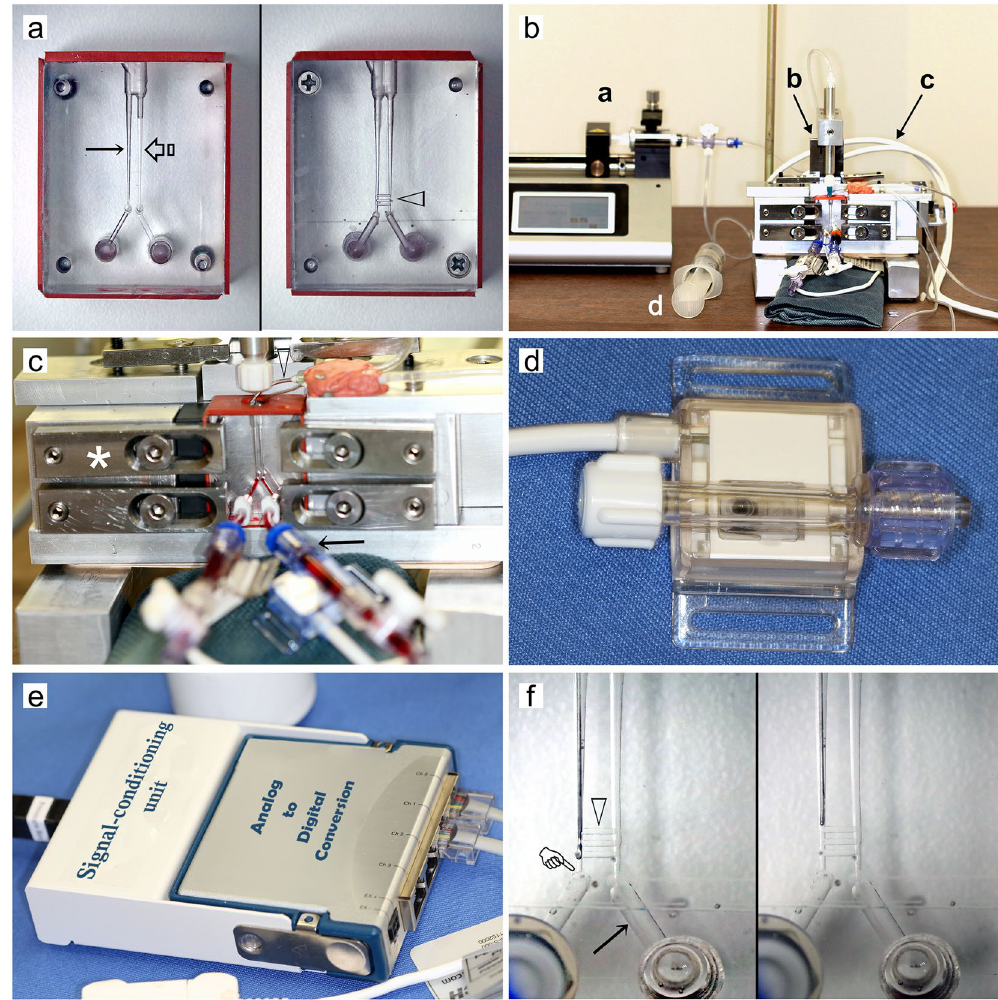
Figure 2. Experimental setup. ( a ) Two models simulating double canals in a single root. Left : The “separate canal model” with two unconnected parallel canals, one for pressure measurement with the irrigation needle inserted (arrow) and the other without needle insertion (open arrow). Right : The “canal anastomosis model” with a similar set of simulated parallel canals connected by anastomosing lateral channels (open arrowhead). The two holes at the bottom of each block are Luer ports for connecting the apical termination of each canal to a pressure sensor. ( b ) Overview of the experimental setup. b-a: precision syringe pump; b-b: Positioning device with inserted metal gauge blocks for precise control of the irrigation needle position within the canal space; b-c: Data acquisition cables linking the pressure sensors (Fig. 2d) to the signal-conditioning unit (Fig. 2e). b-d: 50 mL syringe connected to a two-way valve to refill the delivery syringe in the syringe pump. ( c ) The test unit with set-up clamps (asterisk) compressing against the polycarbonate split-block to achieve a fluid-tight seal. Solid arrowhead: aspiration needle for evacuating excess irrigant; Arrow: PVC tubing connecting a pressure sensor to the Luer port in front of the split-block (Fig. 2a) via a standard Luer connector. Red dye was added to the liquid within the tubing to demonstrate the path from the pressure sensor to the faux apical termination. ( d ) Pressure sensor that records the detected pressure in millivolts. ( e ) Signal-conditioning unit that converts millivolt analogue signals into digital signals. ( f ) Side-venting needles inserted into the anastomosing canal model. Left : Needle inserted to 1 mm above the apical termination of one canal (pointer). Open arrowhead: lateral channels connecting the two adjacent canals. Arrow: extension connecting the canal to the Luer port. Right : Needle inserted to 3 mm above the apical